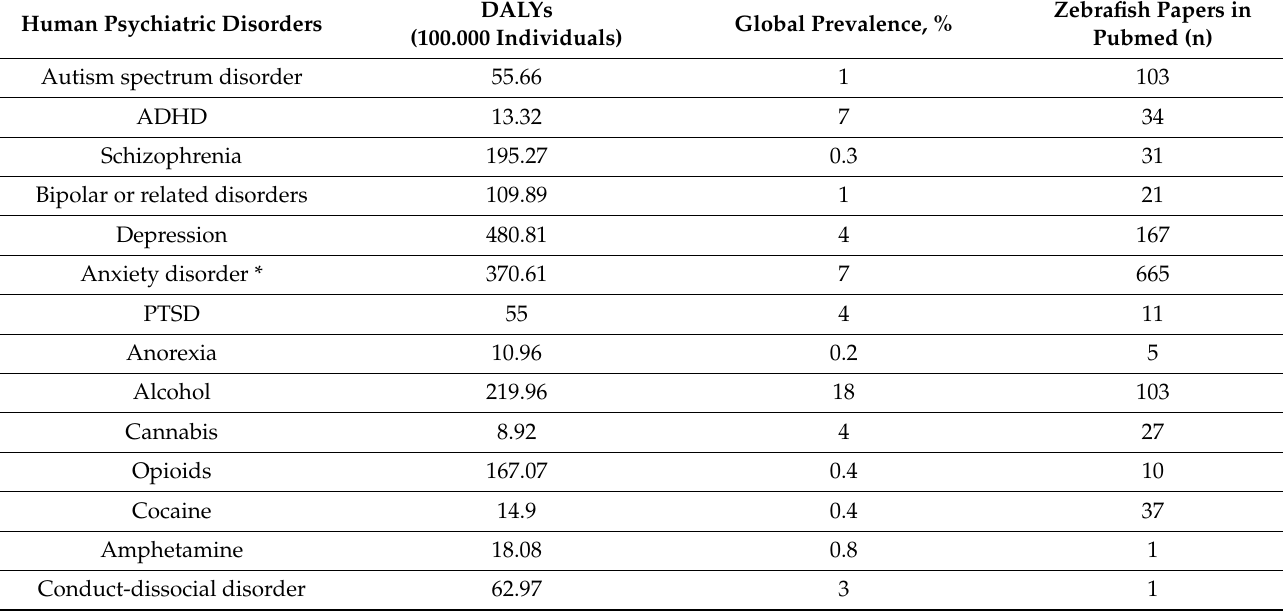
Table 1. Global burden of psychiatric disorders represented as disability-adjusted life year (DALYs), and current state of zebrafish modeling of these disorders (based on Pubmed papers, as assessed in December